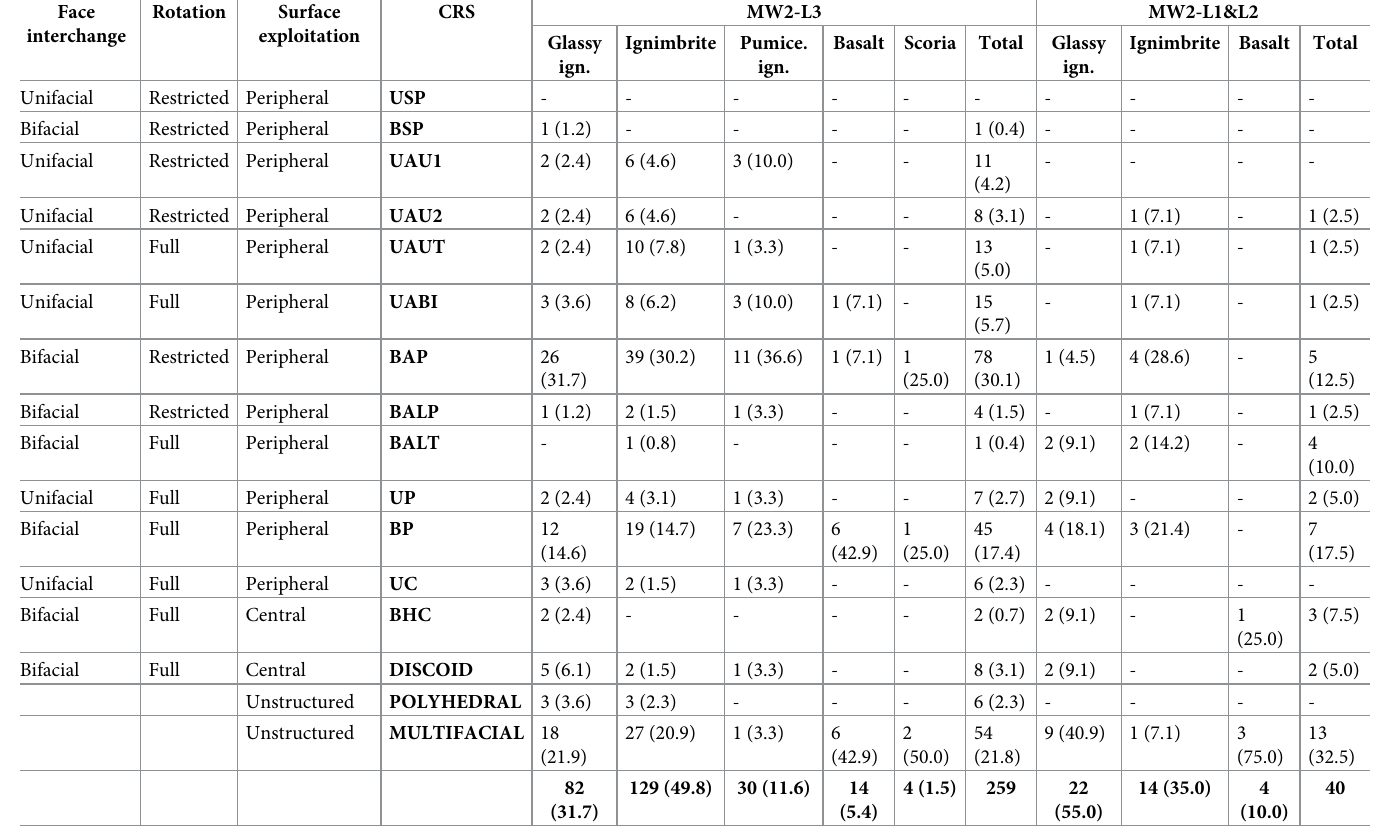
Table 5. Absolute and relative frequencies (in parentheses) of core reduction strategies (per raw materials) employed by occupants of